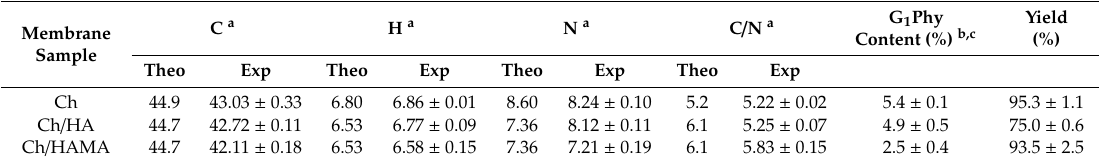
Table 1. Theoretical (Theo) and experimental (Exp) elemental compositions, crosslinker content, and yield percentage for Ch, Ch / HA and Ch / HAMA